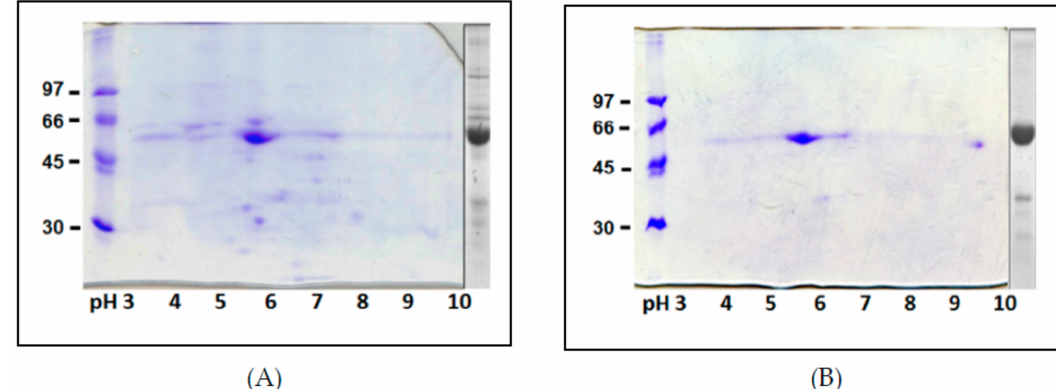
Figure 4. Two-dimensional IEF/SDS-PAGE of TPE ( A ) and highly purified β -vignin ( B ). The 1-D separation is reported to the right of each gel. Molecular masses of protein markers are expressed as